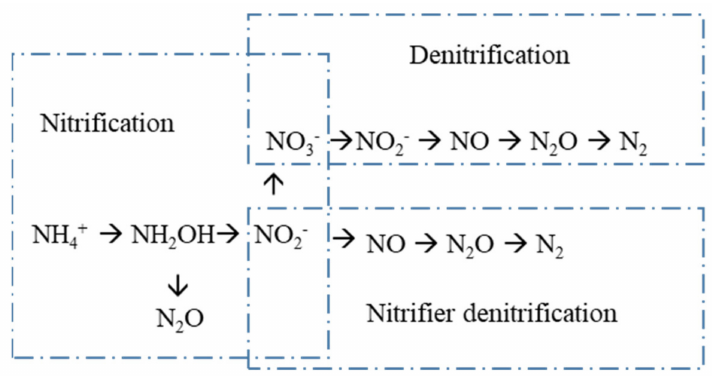
Figure 1. Principle N transformations leading to the emission of N 2 O in